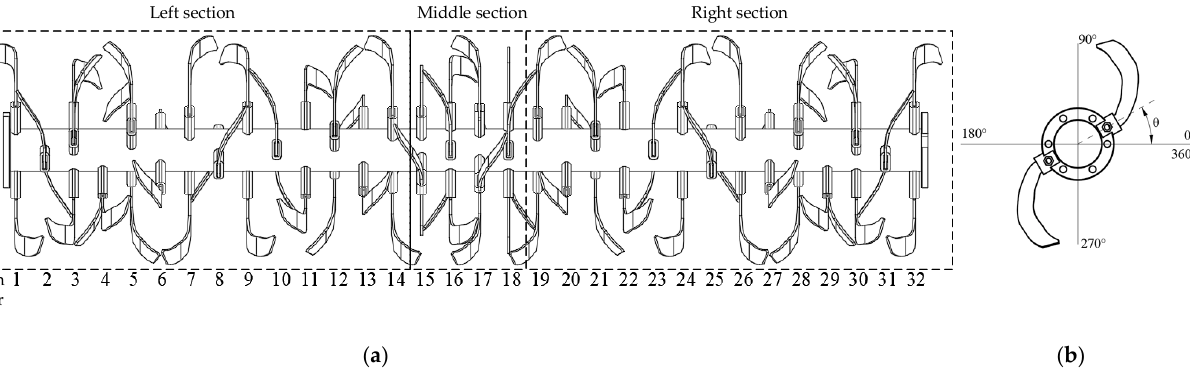
Figure 3. Structure and position angle of rotary tillage device. ( a ) Structure of rotary tillage blades; ( b ) Diagrammatic sketch of the position angle for rotary tillage blades; ( θ ) Position angle of rotary tillage blades.